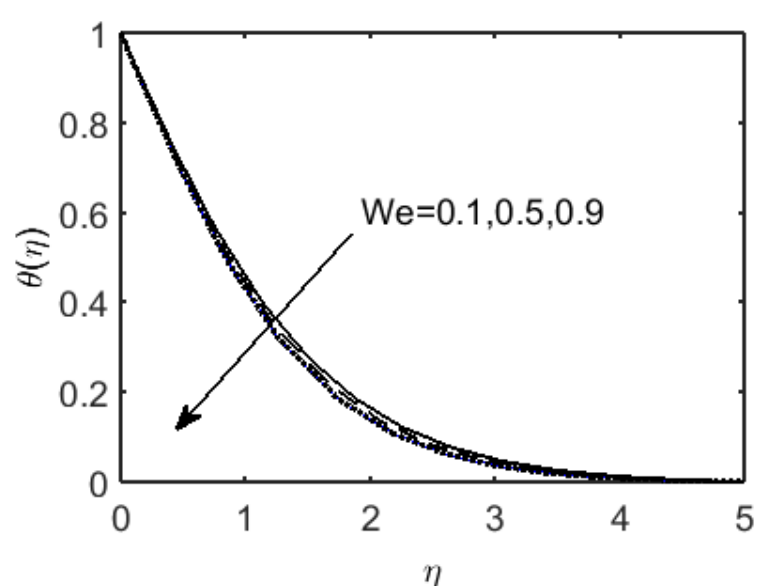
Figure 7. Impact of We on hotness.